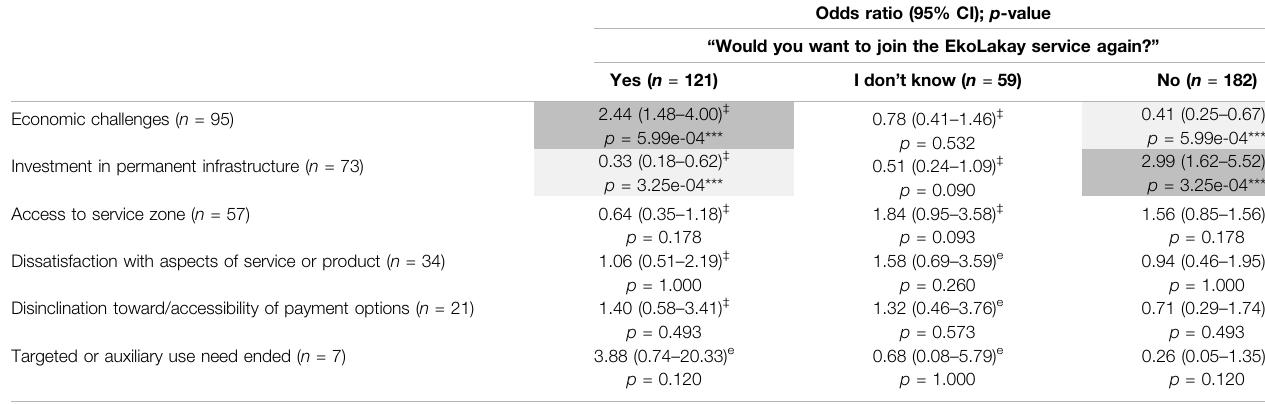
TABLE 7 | Interest in re-subscribing to EkoLakay, by factors affecting subscription termination.